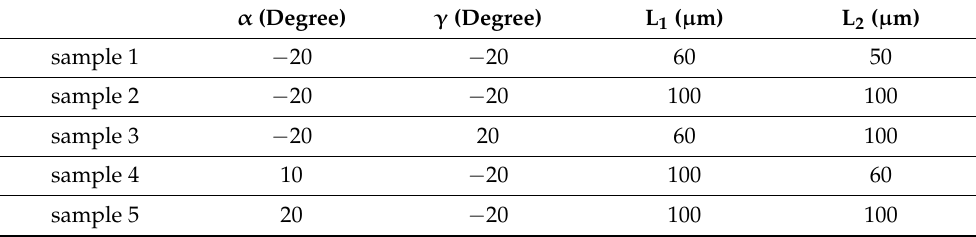
Figure 3. Plots of some samples and their circular dichroism curves for the data set of group 750. Table 1. Sample structure parameter.